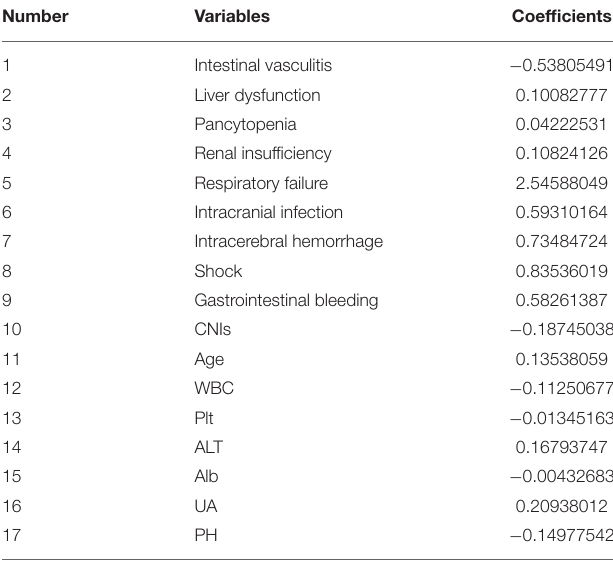
TABLE 5 | Candidate prognostic factors selected by LASSO